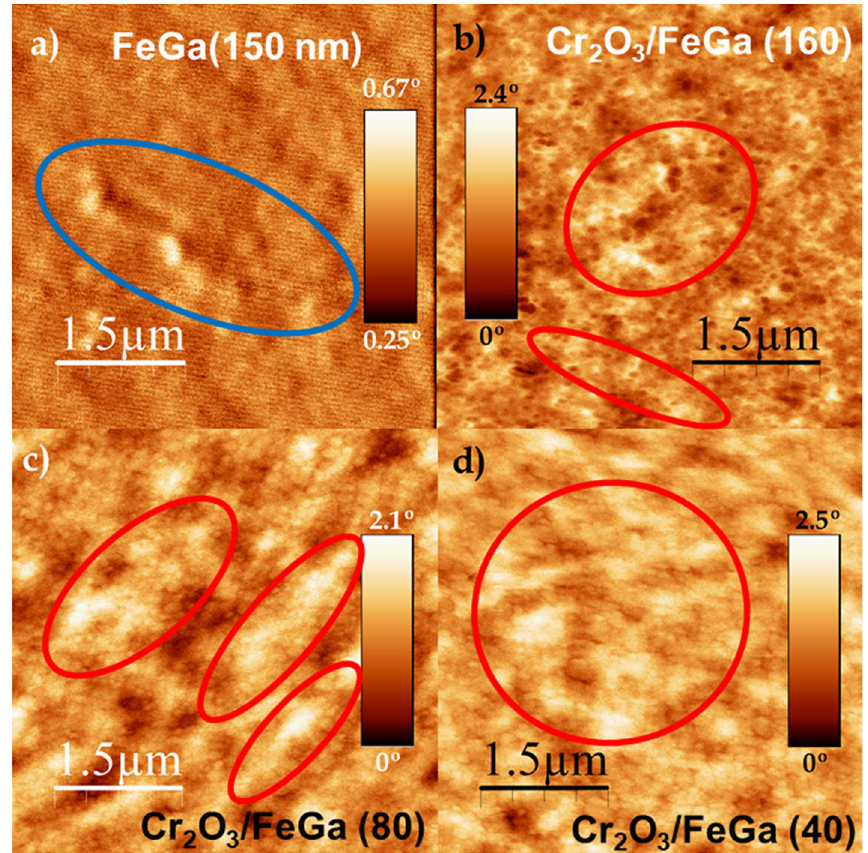
Figure 4. MFM images taken at remanence after an applied magnetic field of 10 kOe was applied in the perpendicular direction. ( a ) 150 nm-thick uncoupled Fe 72 Ga 28 layer. With a blue line it is indicated an example of the magnetic contrast known as ripple. ( b ) Cr 2 O 3 /Fe 72 Ga 28 (160 nm), ( c ) Cr 2 O 3 /Fe 72 Ga 28 (80 nm), and ( d ) Cr 2 O 3 /Fe 72 Ga 28 (40 nm). In ( b ), ( c ) and ( d ), a red line is used to highlight examples of areas where magnetic stripes can be